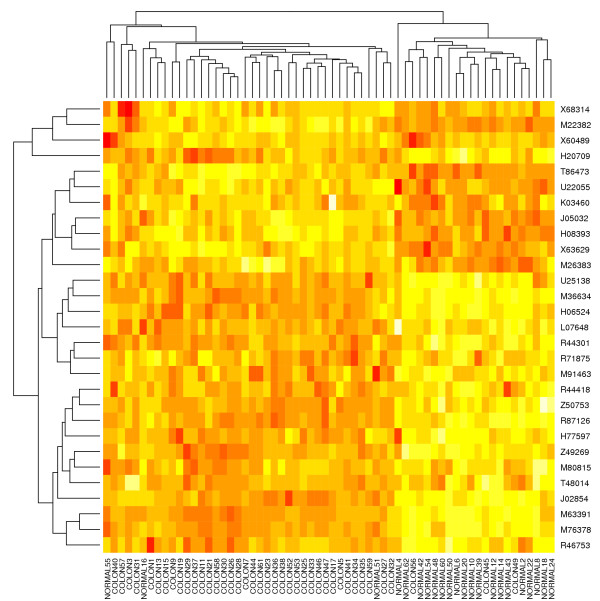
Clustering dendrogram of colon cancer data – First Iteration.